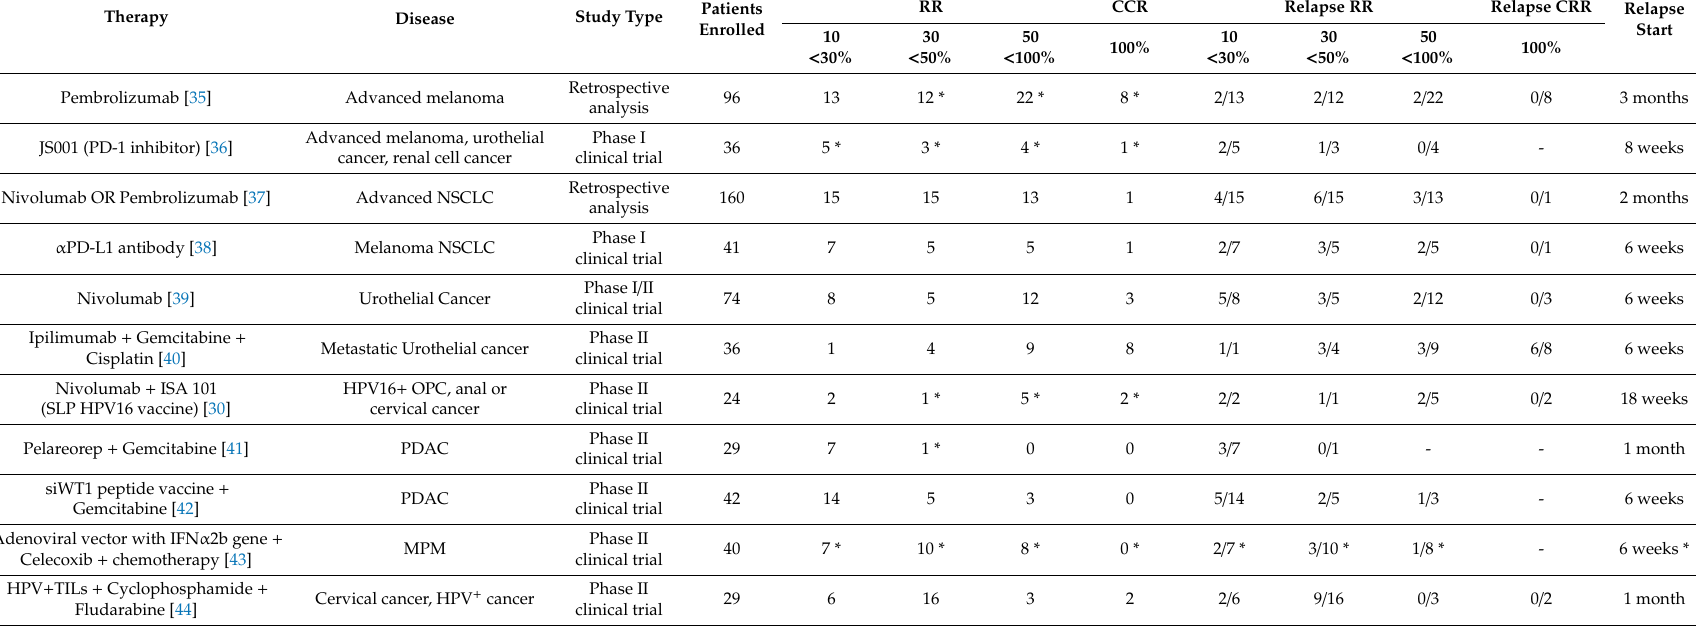
Table 1. Examples of clinical trials resulting in acquired resistance during